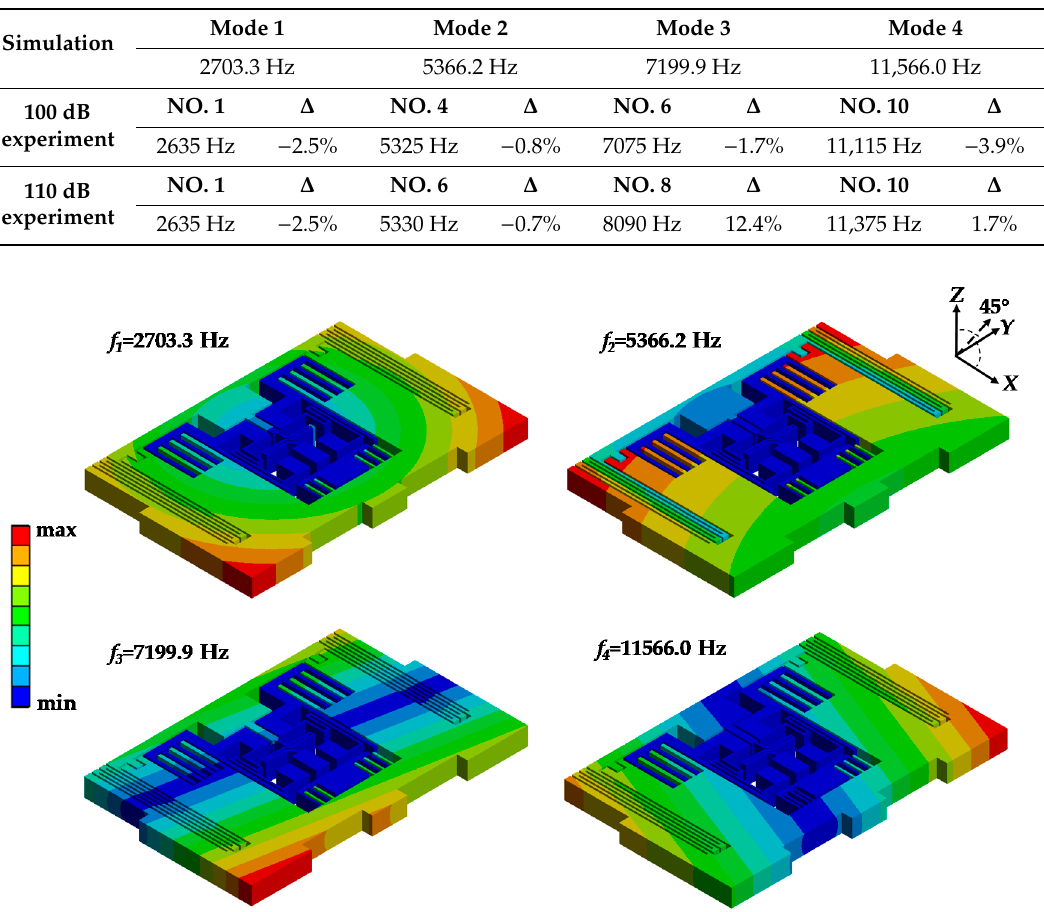
Figure 7. Deformation contours of MPU6050-Y in the first four modes.